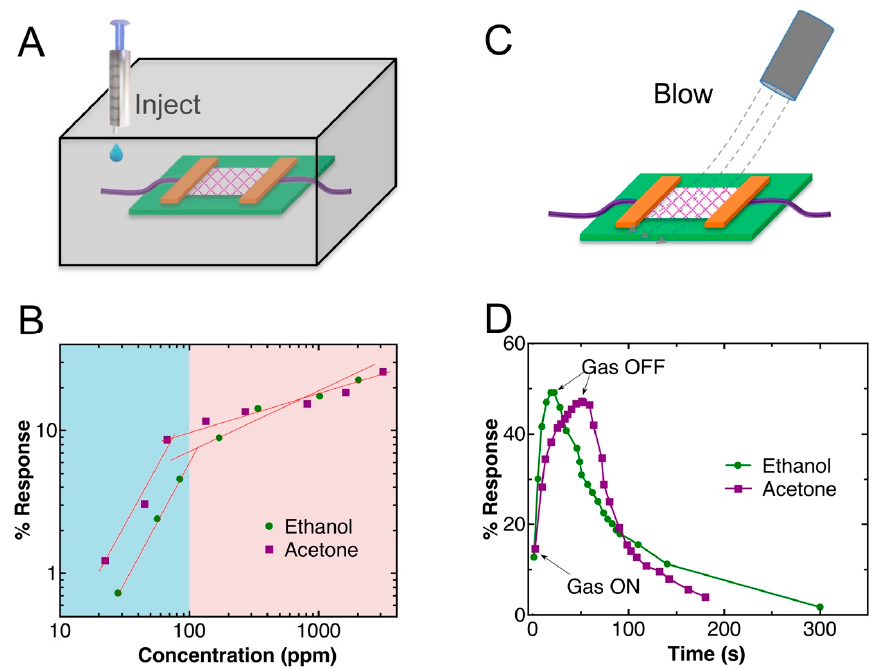
Figure 4. ( A ) A schematic drawing of the structure of gas sensing inside a sealed box. ( B ) Log–log